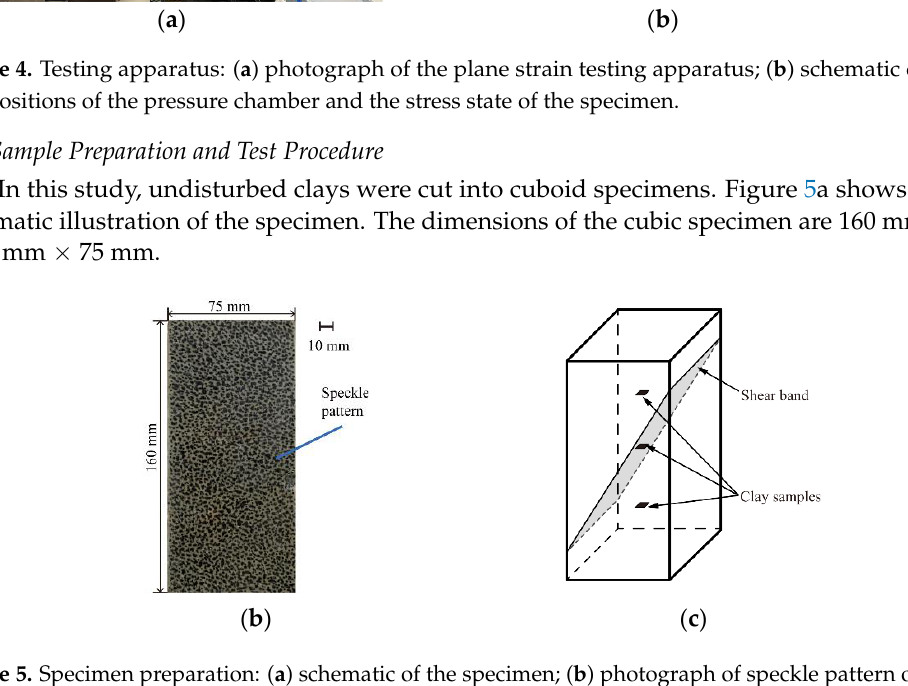
Table 3. Test program.